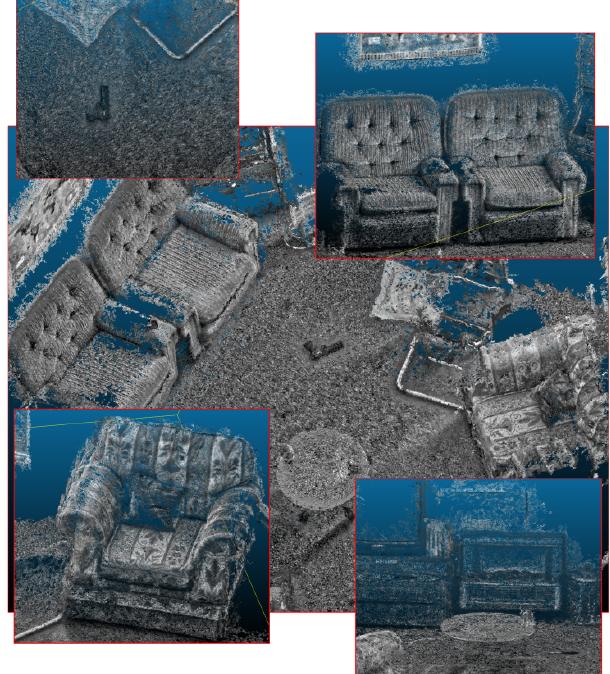
Figure 6. An overview and detailed views of the 3D dense point cloud (Scenario